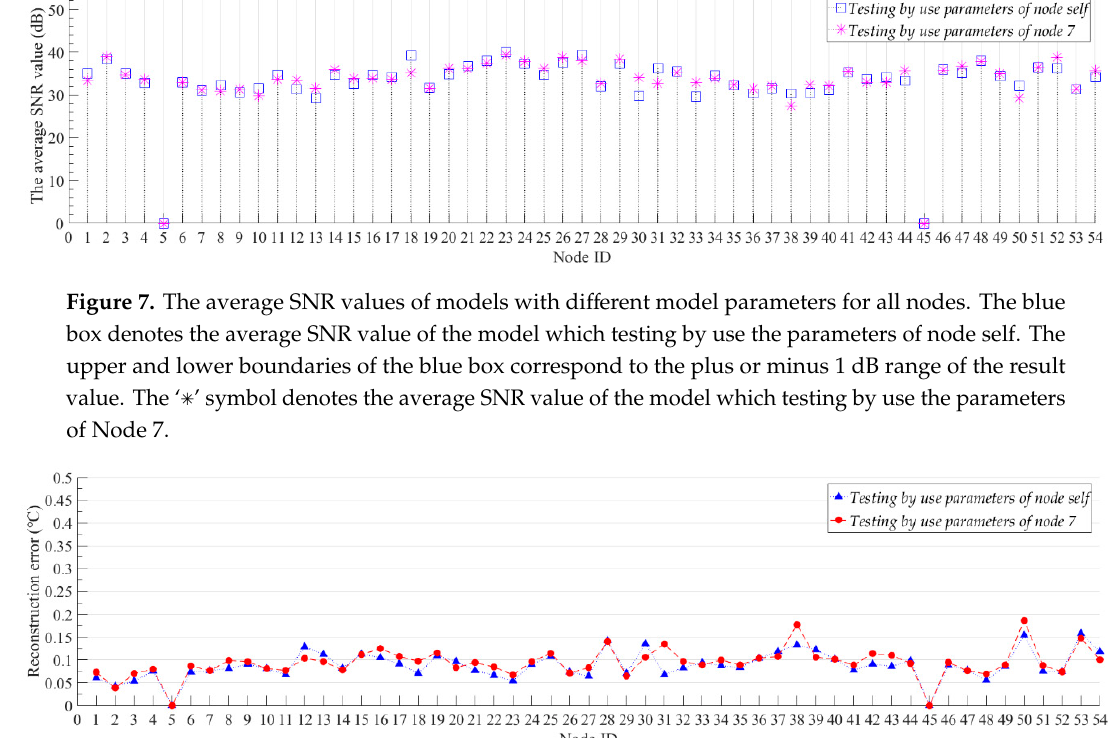
Figure 8. The reconstruction error of models with different model parameters for all nodes. The red line shows the reconstruction error of the model which testing by use the parameters of Node 7. The blue line shows the reconstruction error of the model which testing by use the parameters of node self. The reconstruction error is the average value of all sample points in node.